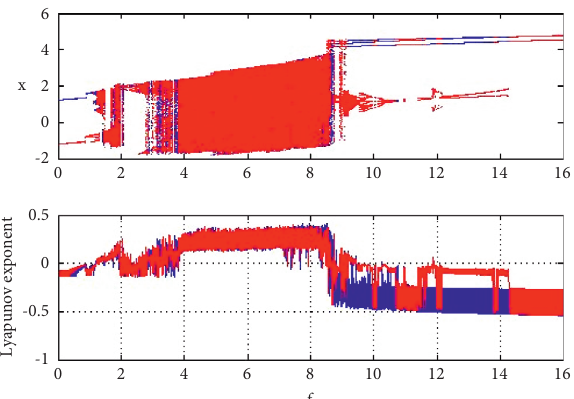
Figure 11: Bifurcation diagrams and its corresponding Lyapunov exponents with α system parameters are